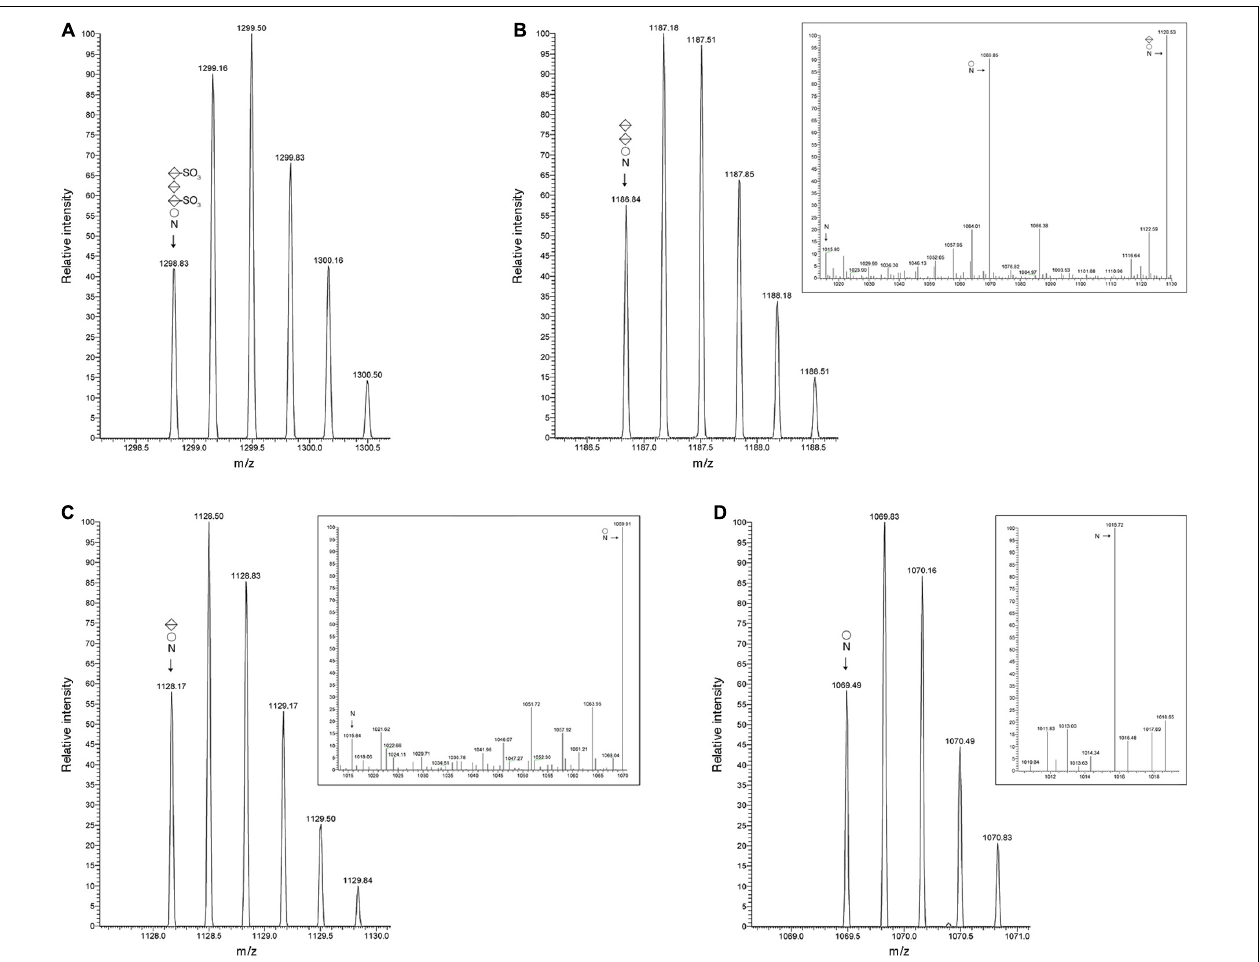
FIGURE 2 | S-layer glycoprotein N-glycosylation is compromised in cells of the (cid:49) vng1062G , (cid:49) vng1066C , and (cid:49) vng1067G strains. (A) LC-ESI MS profile of an S-layer glycoprotein Asn-479-containing peptide from parent strain cells modified by a tetrasaccharide comprising a hexose, a sulfated hexuronic acid, a hexuronic acid and a sulfated hexuronic acid. (B) In (cid:49) vng1062G strain cells, the same fragment is only modified by the first three sugars of the tetrasaccharide, with no sulfation of the hexuronic acid at position two. The MS/MS profile of this peptide reveals breakdown products corresponding to the same peptide modified by the first two sugars and the first sugar of the tetrasaccharide and by no sugars (insert). (C) In (cid:49) vng1066C strain cells, the same fragment is only modified by the first two sugars of the tetrasaccharide, with no sulfation of the hexuronic acid at position two. The MS/MS profile of this peptide reveals breakdown products corresponding to the same peptide modified by the first sugar and by no sugars (insert). (D) In (cid:49) vng1067G strain cells, the same fragment is only modified by the first sugar of the tetrasaccharide. The MS/MS profile of this peptide reveals a breakdown product corresponding to the same peptide not modified by sugars (insert). In each panel, circles correspond to hexoses, split diamonds correspond to hexuronic acids and the N corresponds to the Asn-479-containing